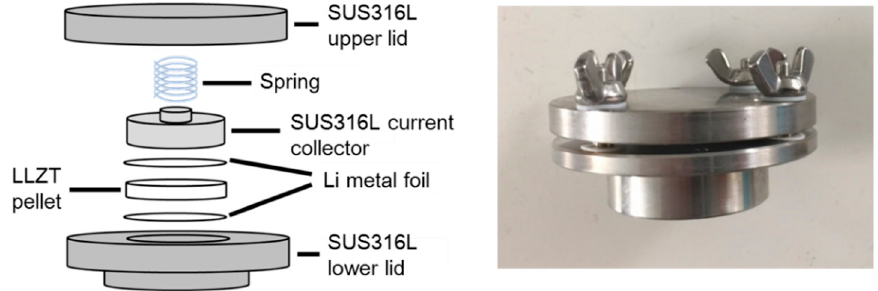
Figure 1. Illustration (left) and photo of cell fixture for composing a lithium-garnet-type Li 7-x La 3 Zr 2-x Ta x O 12 -lithium (Li/LLZT/Li) symmetric cell.